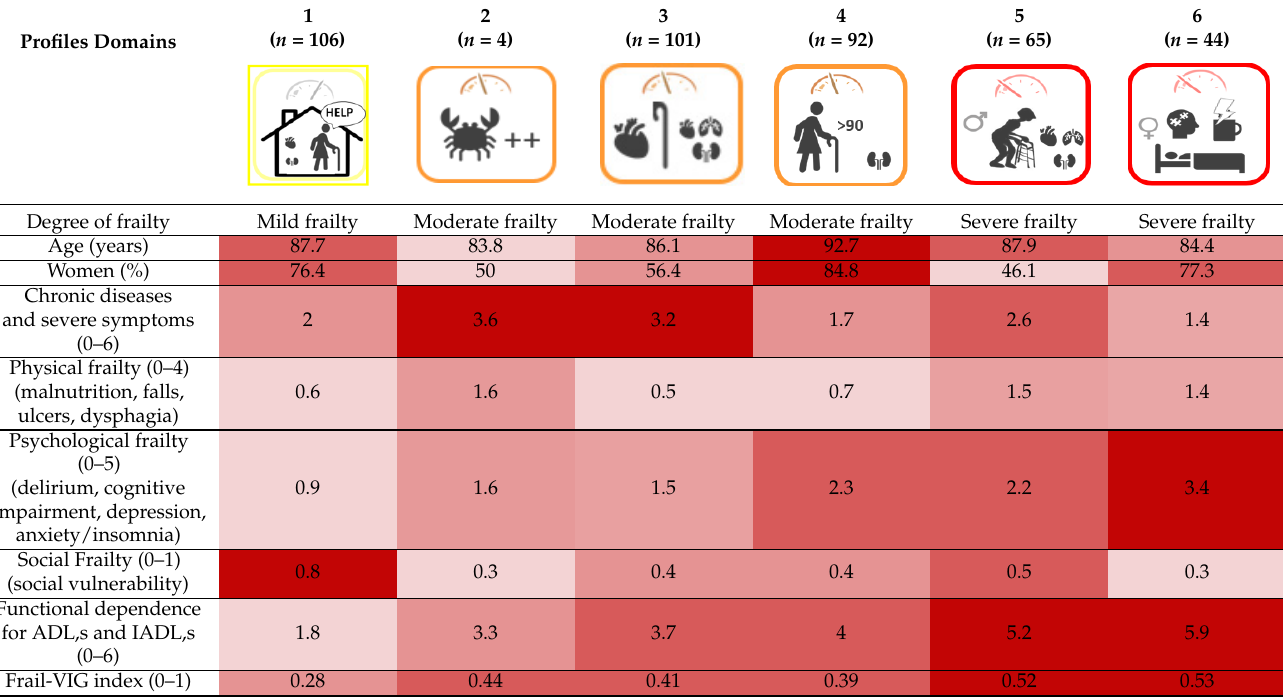
The profiles are ordered according to the similarity between them. The darker the color, the higher frequencies or values of the variables. Frail-VIG index, higher scores represent a higher degree of frailty. Abbreviations: ADLs, Activities of Daily Living; IADLs, Instrumental Activities of Daily Living.